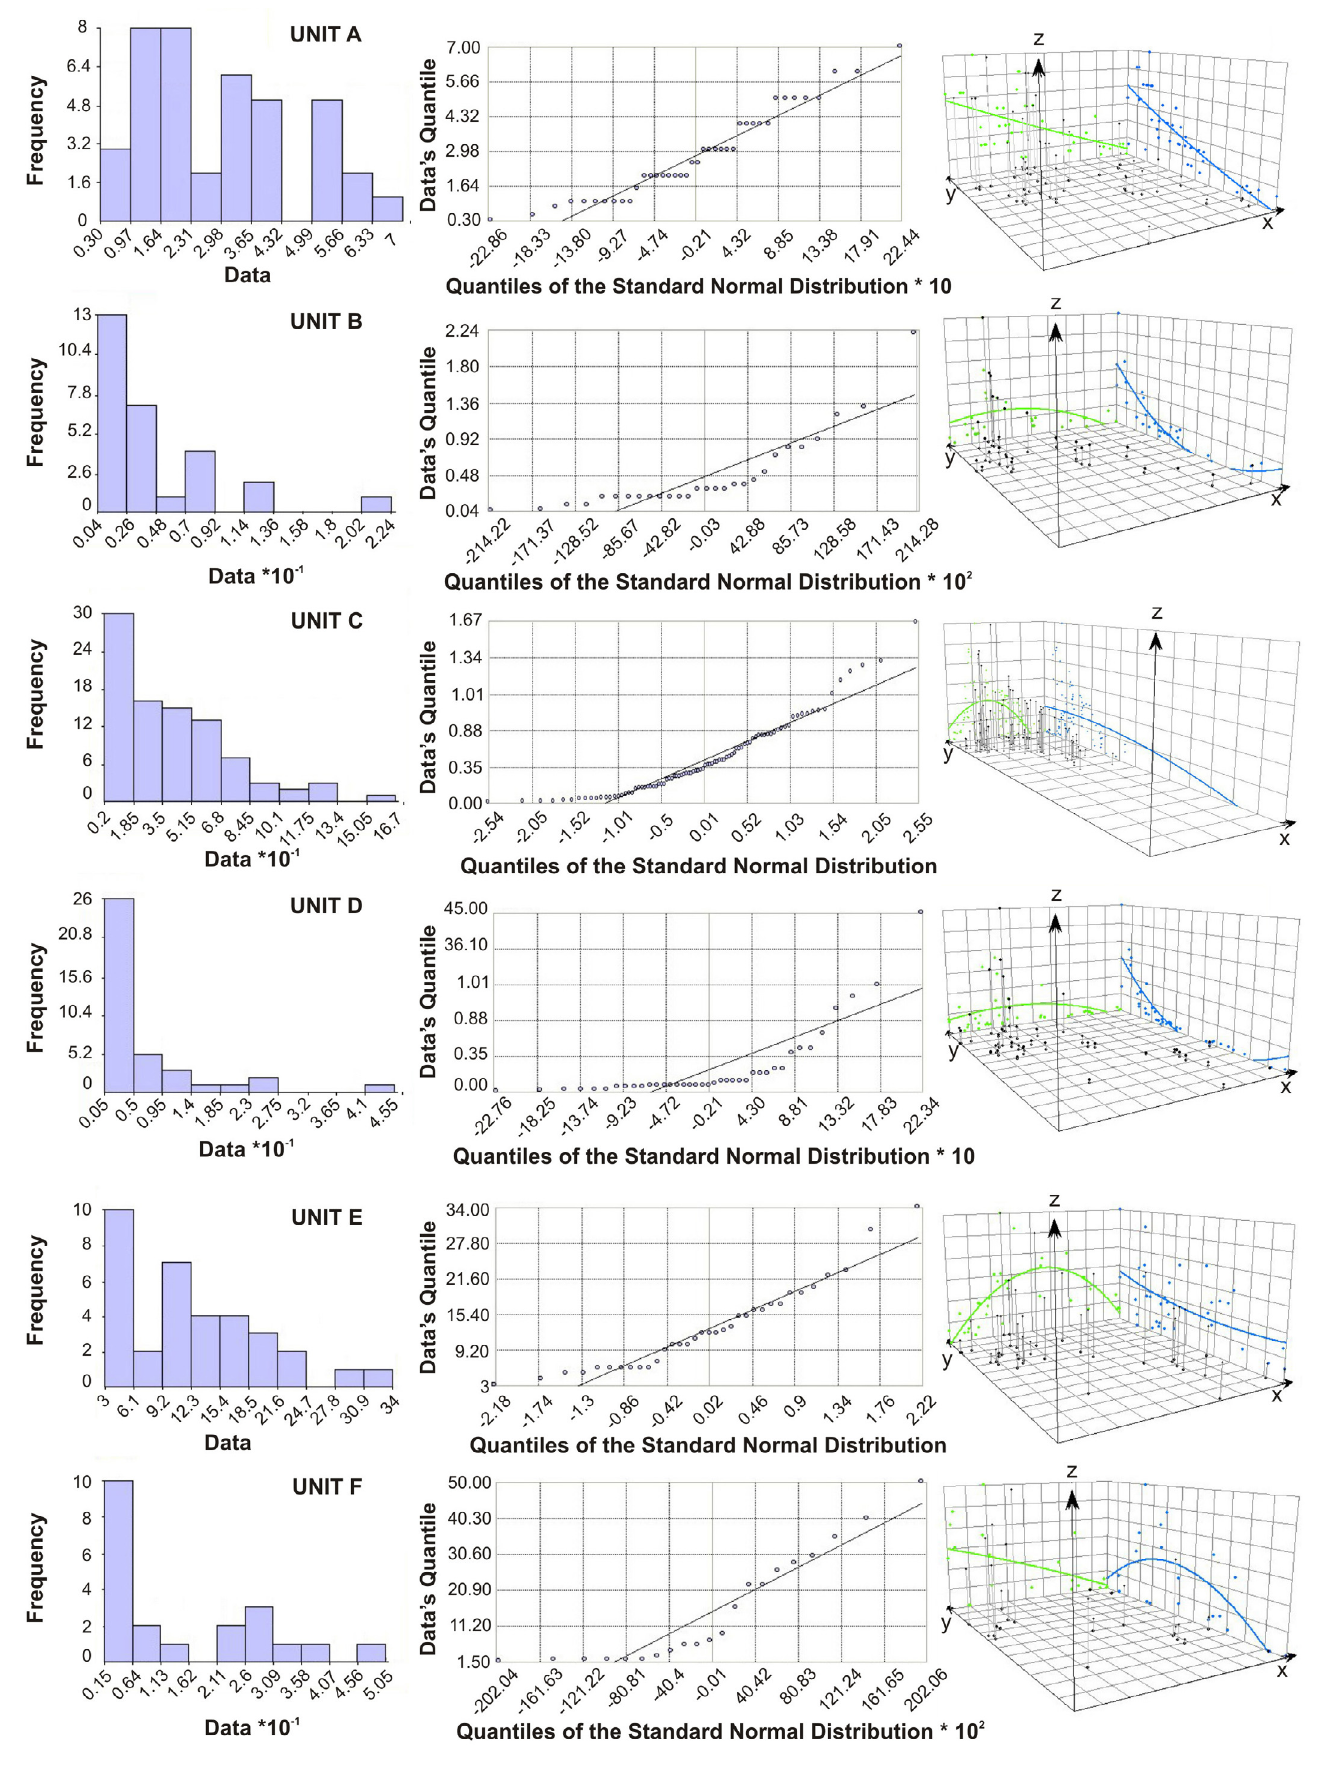
Figure 6. Histograms (left), QQplots (middle) and 3D perspective graphs (right) of each of the 122 BC Etna fallout unit thicknesses (as indicated left). The 3D perspective graphs show the thickness points of each volcanic unit on the xy (black), xz (blue) and yz (green)